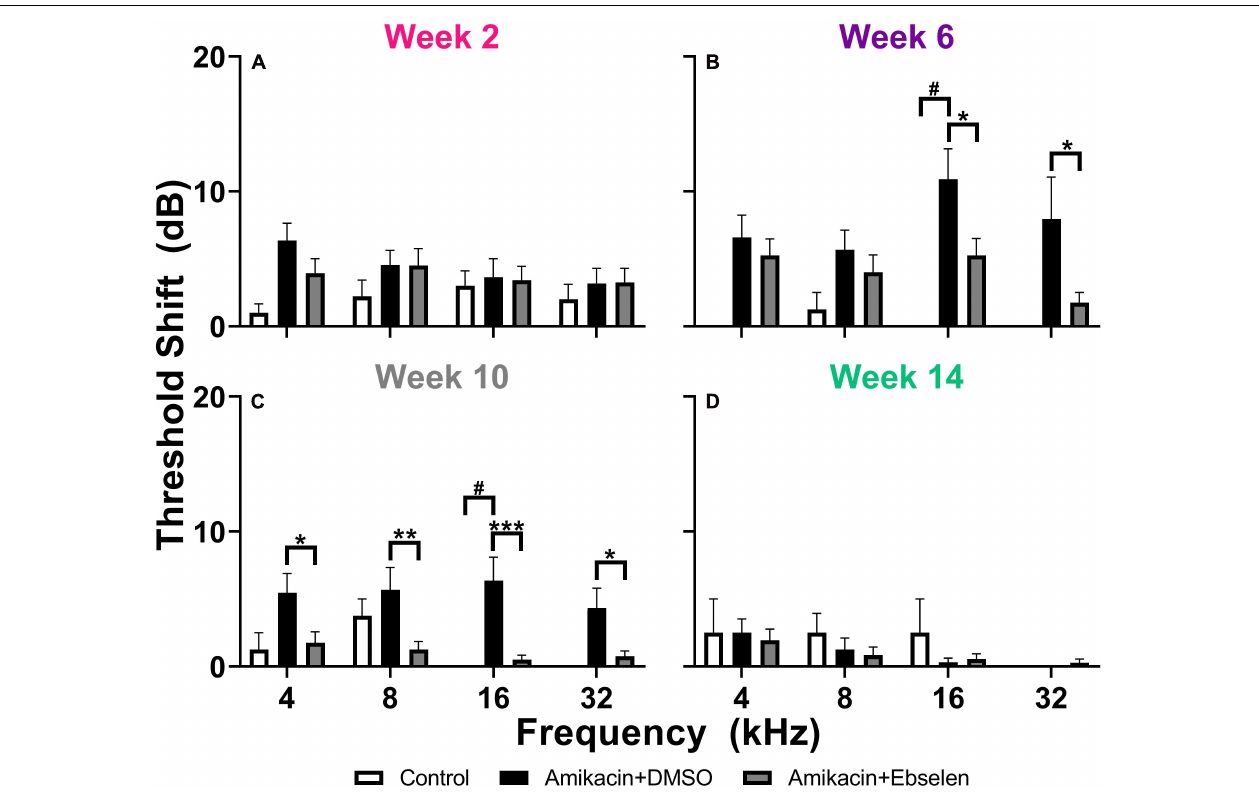
FIGURE 2 | Averaged ABR threshold shifts comparing testing groups at different epochs ( A: week 2, B: week 6, C: week 10, D: week 14) after the start of treatment. ABRs were collected for 4, 8, 16, and 32 kHz. Shifts represent the specific timepoint minus the baseline ABR value for each group. Data are represented by threshold shift means and standard errors. Post hoc tests determined significant differences between testing groups, which are indicated as follows: #, between control and DMSO treated animals; # (gray), between control and ebselen treated animals; ∗ , between DMSO and ebselen treated animals.